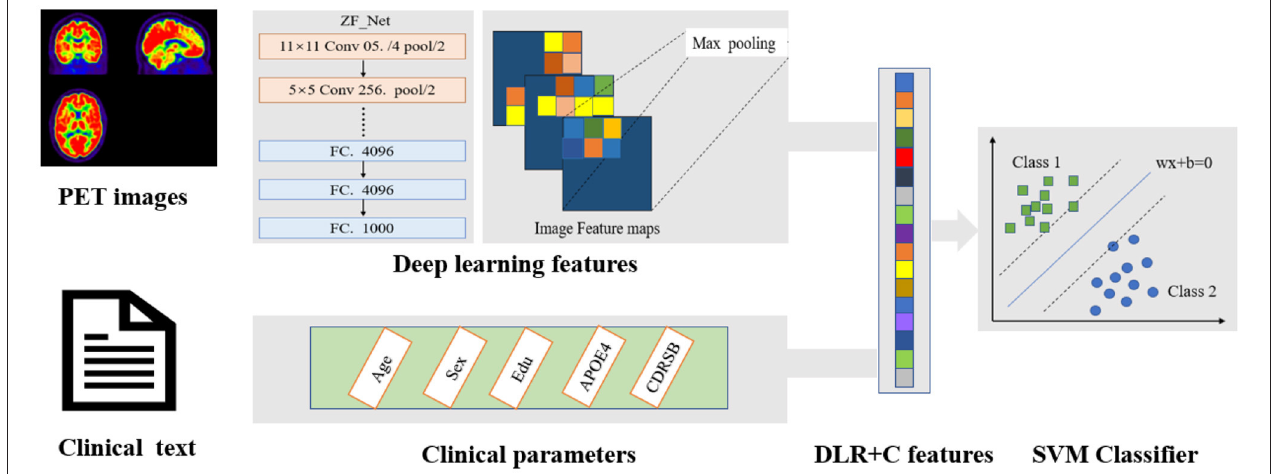
FIGURE 2 | The overall pipeline of DLR model. The pre-trained ZF-Net model acted as an feature encoder of the input images. Then the DLR features combined clinical parameters were classified by a SVM